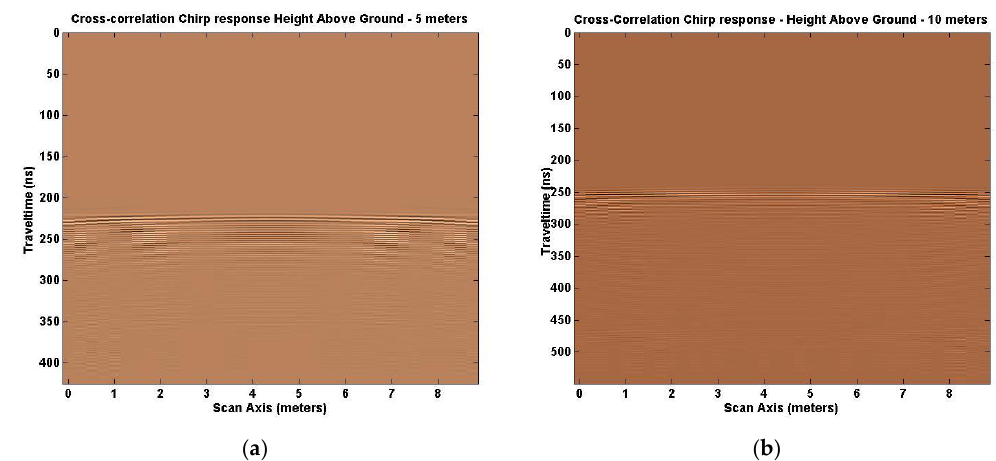
Figure 9. ( a ) Gazdag [17] translated output response of SA1 for 5-m height chirp excitation. ( b ) Gazdag [17] translated output response of SA1 for 10-m height chirp excitation.